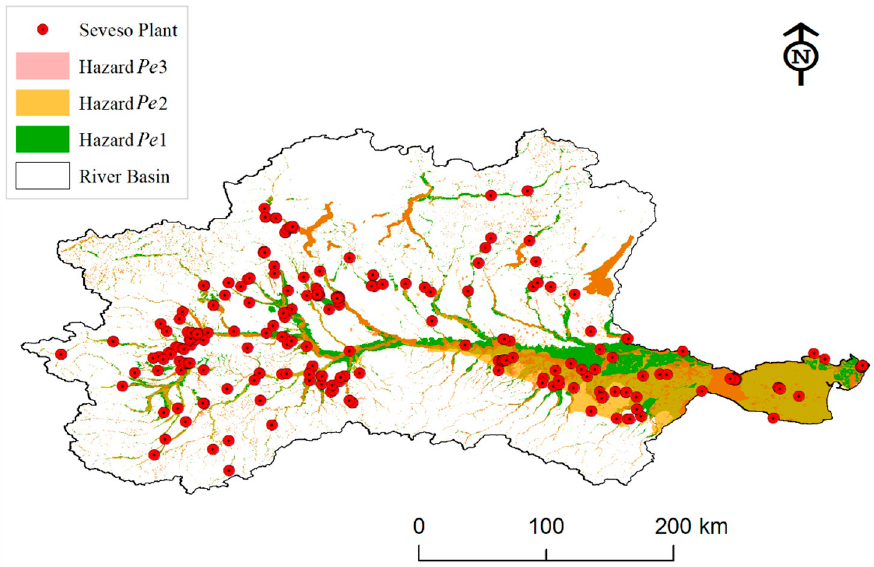
Figure 5. Distribution of major accident hazard establishments in Pe 1, Pe 2 and Pe 3.